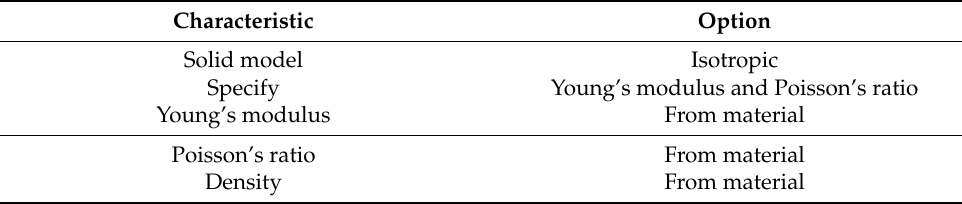
Table 5. Linear Elastic material for the two brake systems.